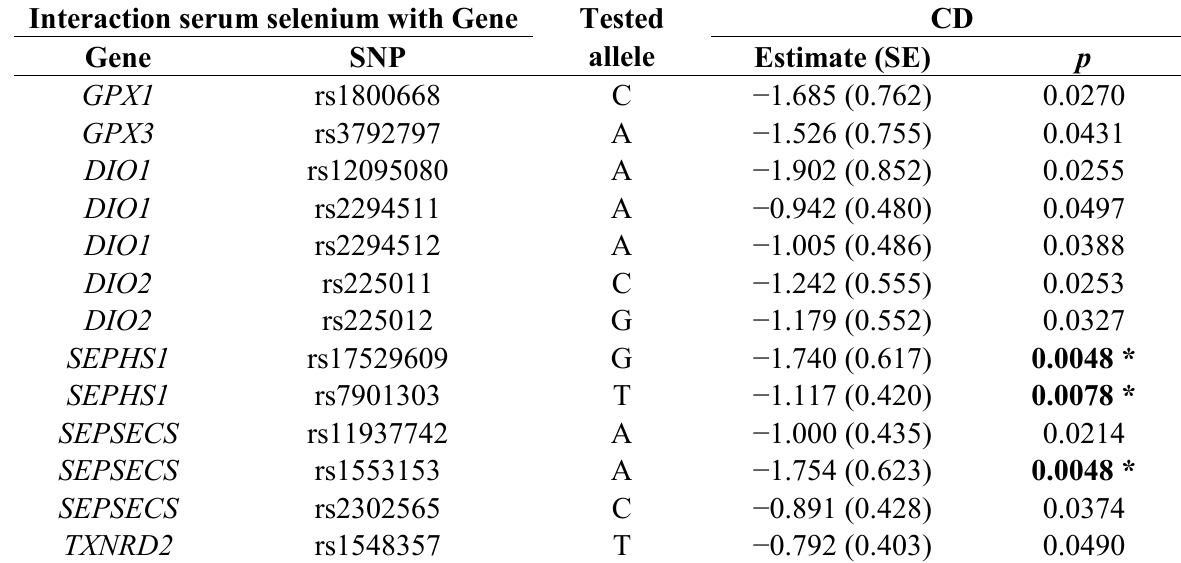
Table 5. Gene-serum selenium interaction on